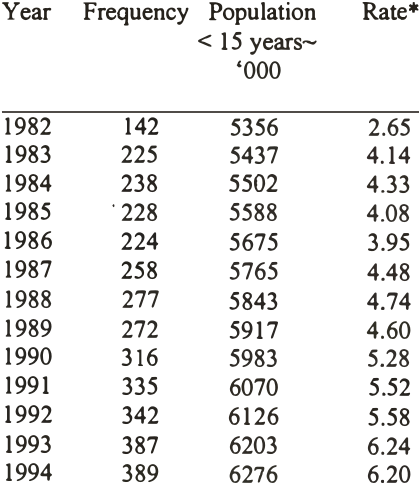
Table 7: Age specific incidence rates of childhood malignancy :